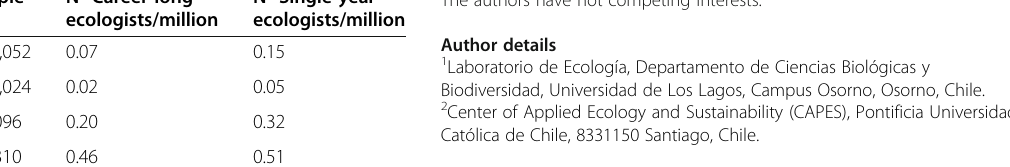
Table 7 No. of ecologists in the four most scientifically- productive Latin American countries (From Tables S-6 and S-7 by Ioannidis et al. [3]), standardized by population size